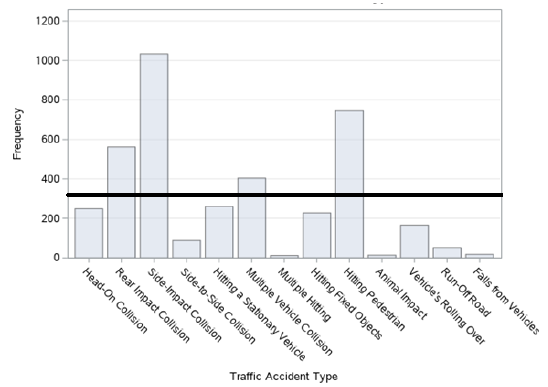
Figure 2. Bar graph of traffic accidents in Şişli district by accident type.